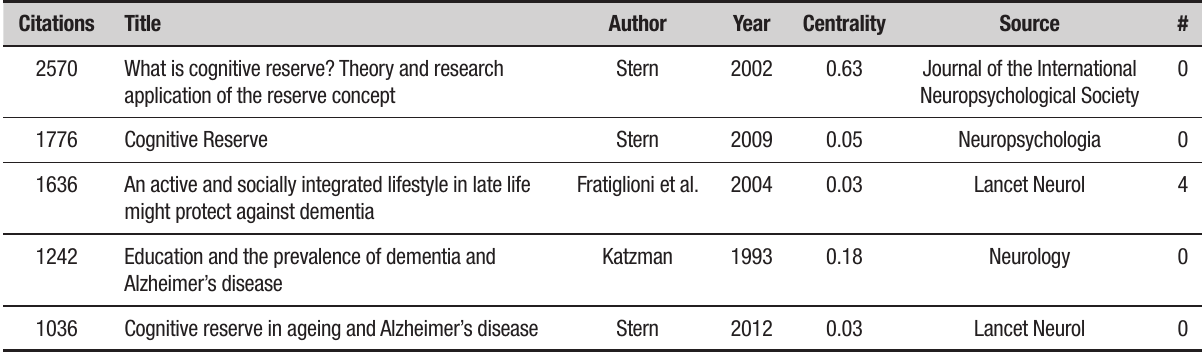
Table 2. Top-cited articles on Cognitive Reserve and Dementia.